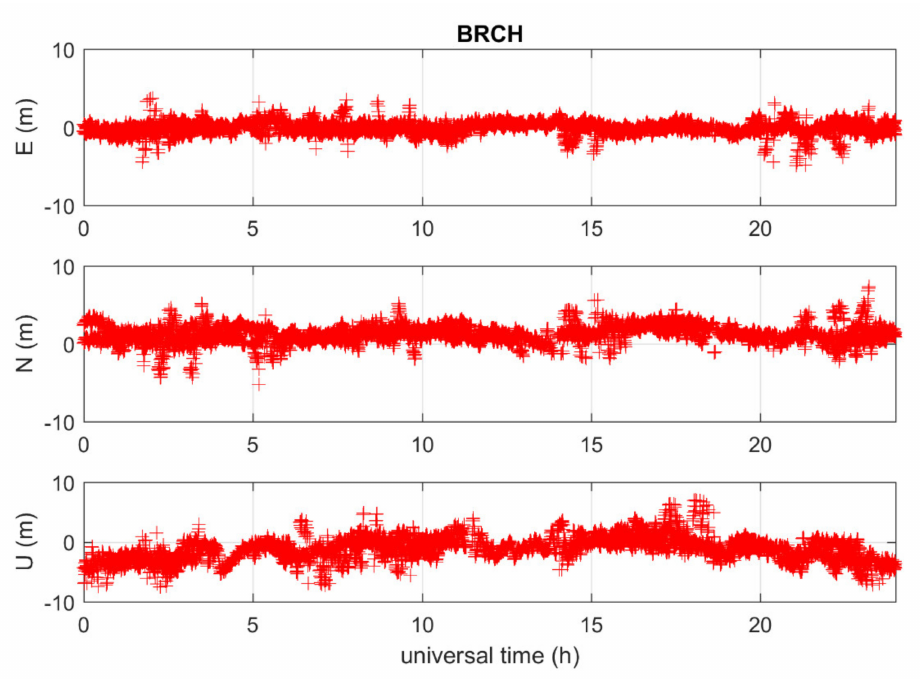
Figure 11. Positioning error scatters of B3I SPP without DCB or TGD correction at BRCH station.